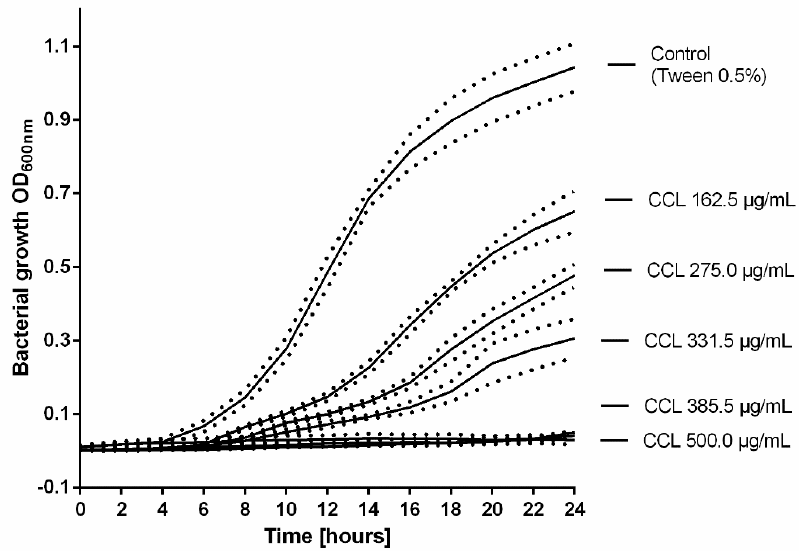
Figure 6. The growth profile of MRSA (ATCC 43300) treated with increasing concentrations of C. collinum ethanolic leaves extract (CCL EtOH 50%). The results are plotted as means of three experiments ± SEM (dotted line), the control was the solvent 0.5% Tween 80.